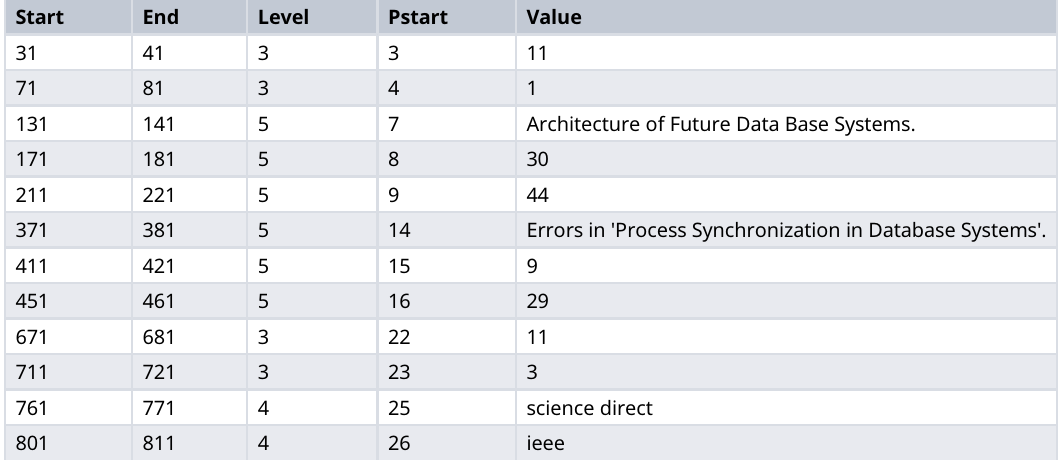
Table 2. tTable of Child Table for initial